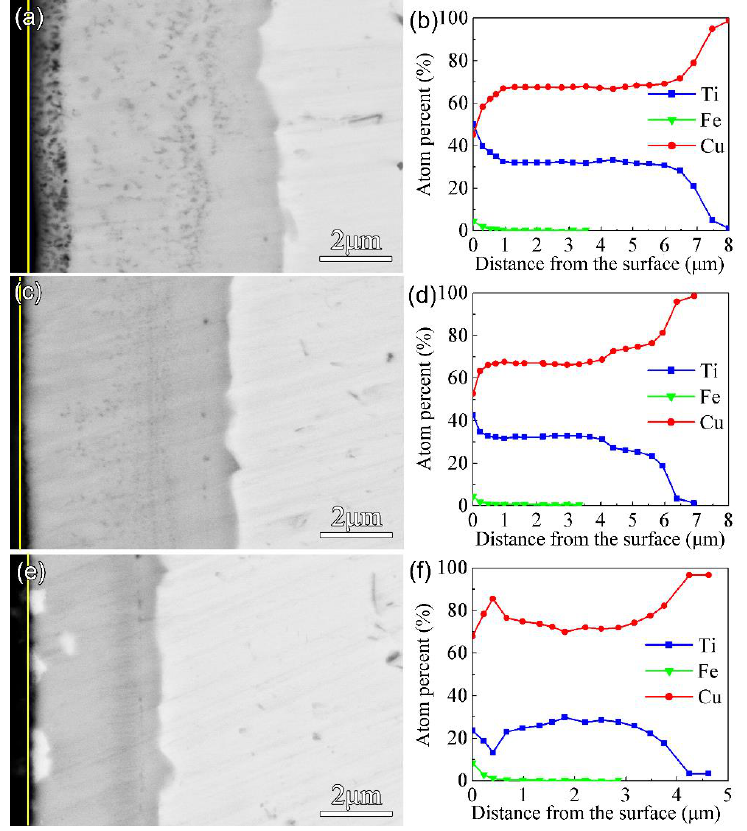
Figure 9. BSEM (backscattered scanning electron microscopy) micrographs of the cross-sectional surface and EDS results along the cross-sectional profile after plasma nitriding at 650 °C for 4 h: ( a ) and ( b ) for F1; ( c ) and ( d ) for F2; and ( e ) and ( f ) for F3.